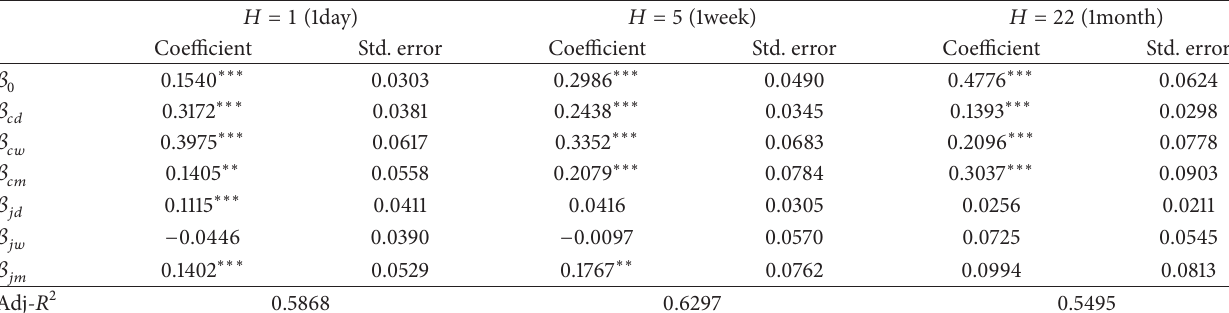
Table 4: Estimation results of the HAR-CJ